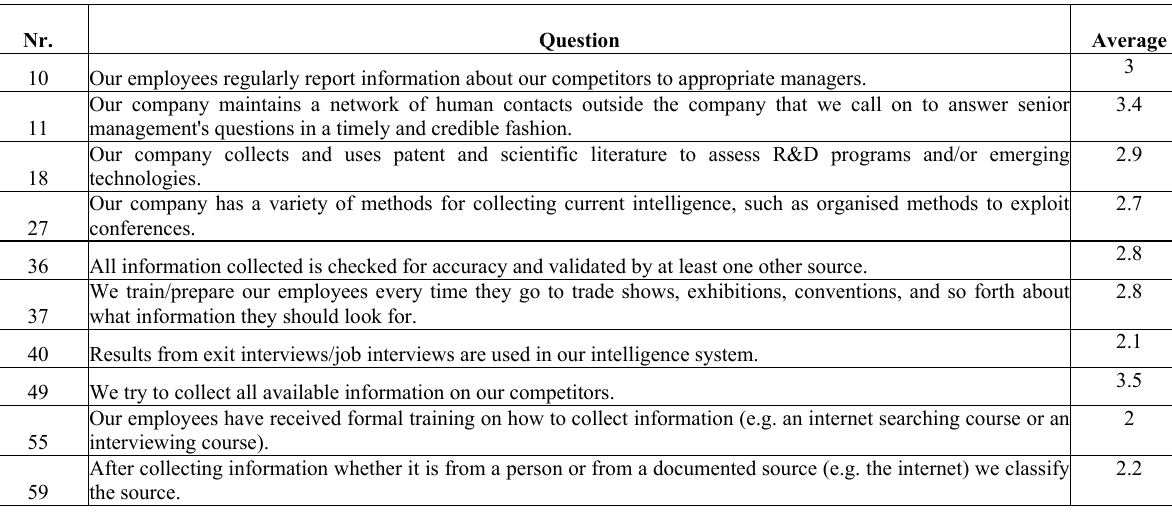
Table 9: Percentage of information obtained from Employees within your organization People outside your organization Electronic information Published information Table 10: Results of collection questions